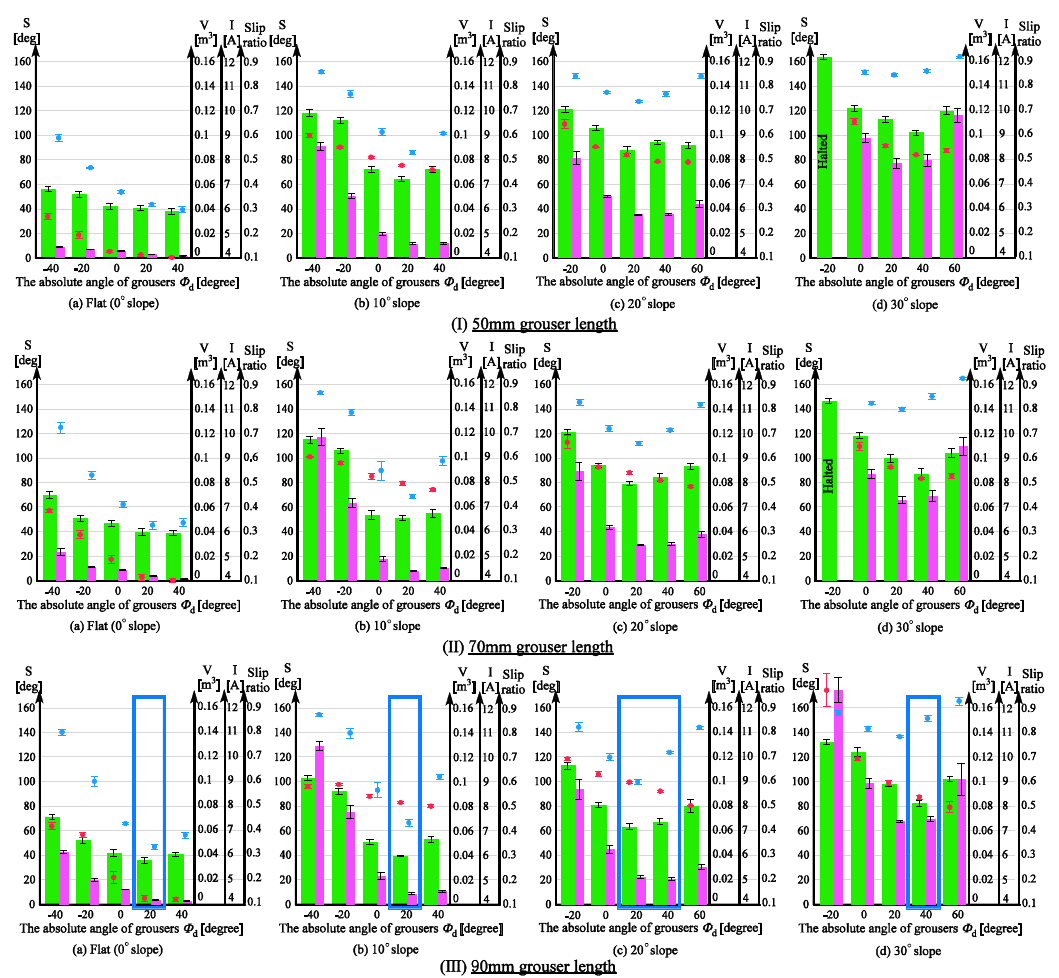
Figure 13. Mobility test results for wheeled rovers equipped with assistive grouser mechanism with grouser length: ( I ) 50 mm; ( II ) 70 mm; ( III ) 90 mm on sand surface inclination angles: ( a ) Level inclination; ( b ) 10 degrees; ( c ) 20 degrees; ( d ) 30 degrees.